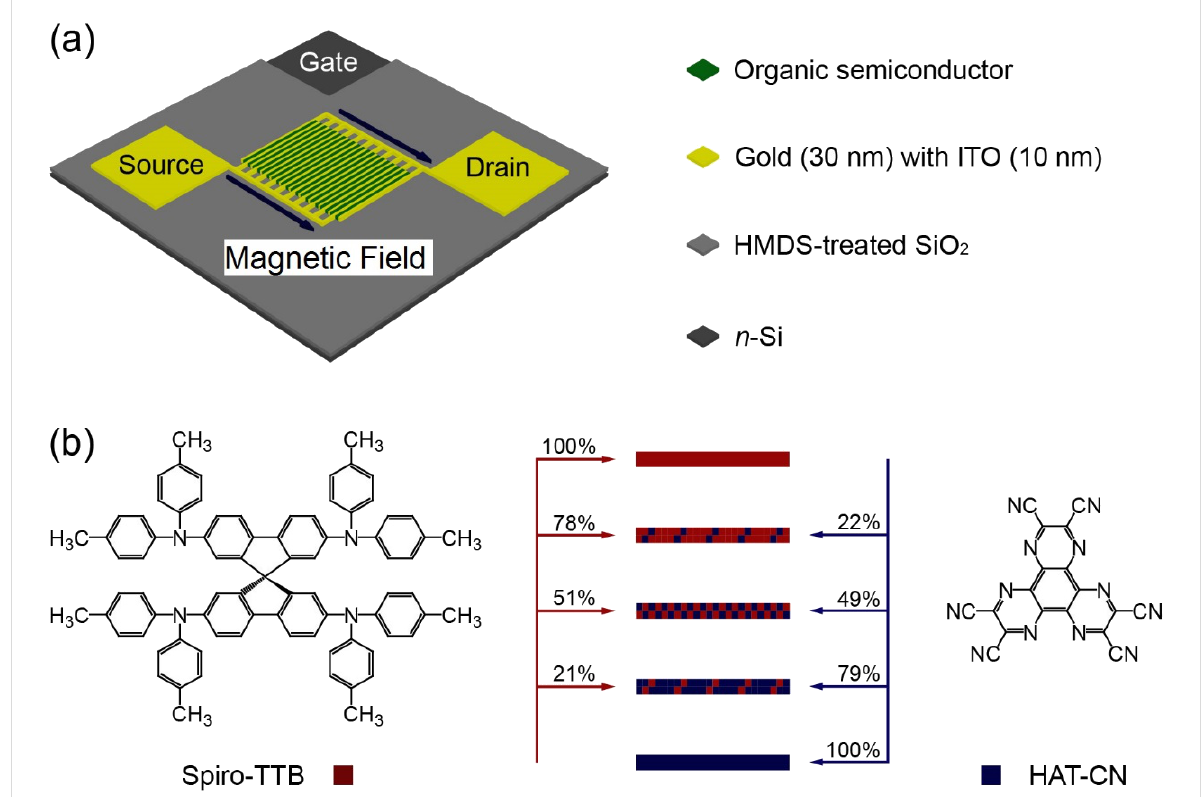
Figure 1: (a) Device layout of a bottom-contact organic field-effect transistor, showing n -Si as gate electrode, HMDS-treated SiO 2 as gate dielectric, gold with ITO as source and drain electrodes and organic semiconductor. (b) The chemical structures of Spiro-TTB and HAT-CN, including mixing compositions of 78:22, 51:49 and 21:79 for Spiro-TTB/HAT-CN, respectively. For a better overview, the organic semiconductor thin film is only depicted in the region of the transistor